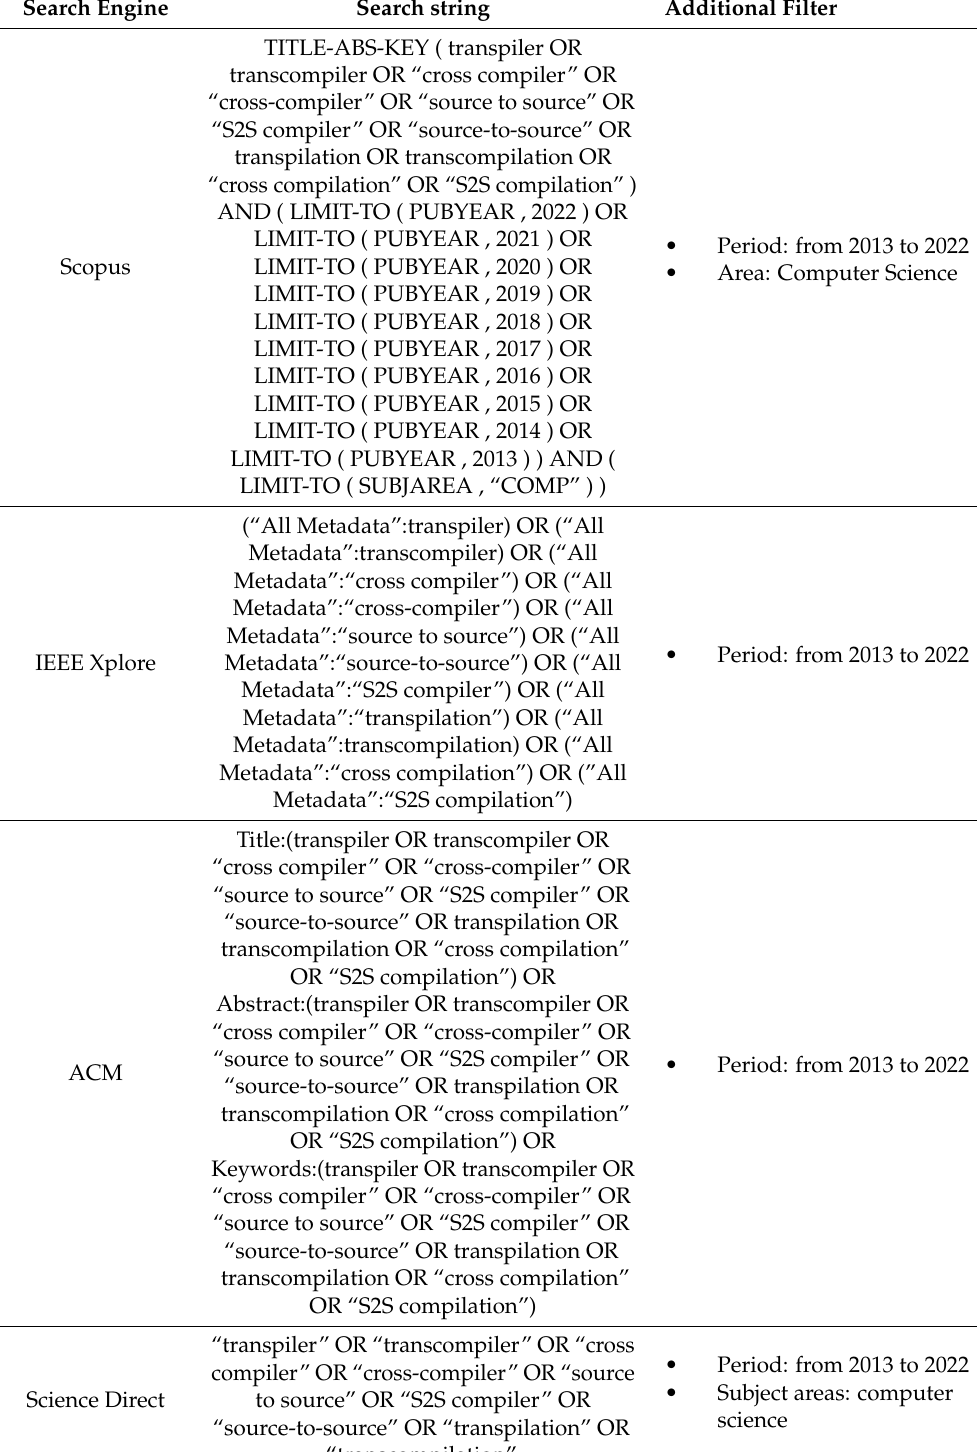
Table 3. Search strings.